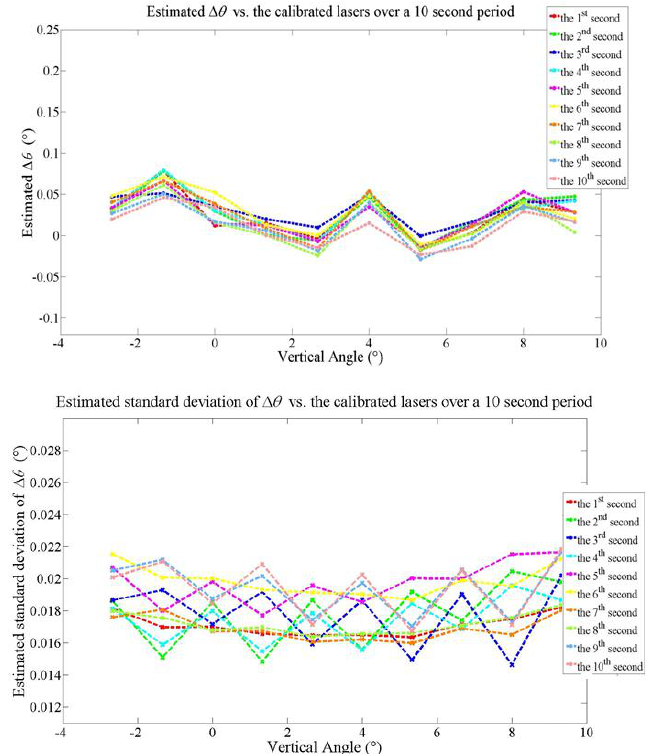
Figure 15. Estimated Δθ for Dataset 2 over a 10 second period (( a ) top). The standard deviations of estimated Δθ by the calibration for Dataset 2 over a 10 second period (( b )